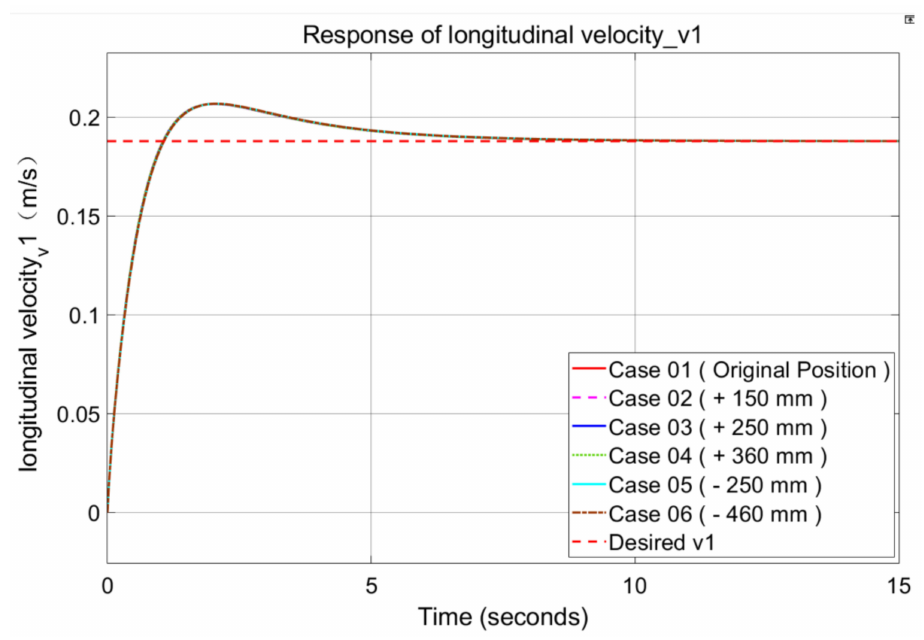
Figure 21. Response of the longitudinal velocity ( δ v 1 ) with controller.